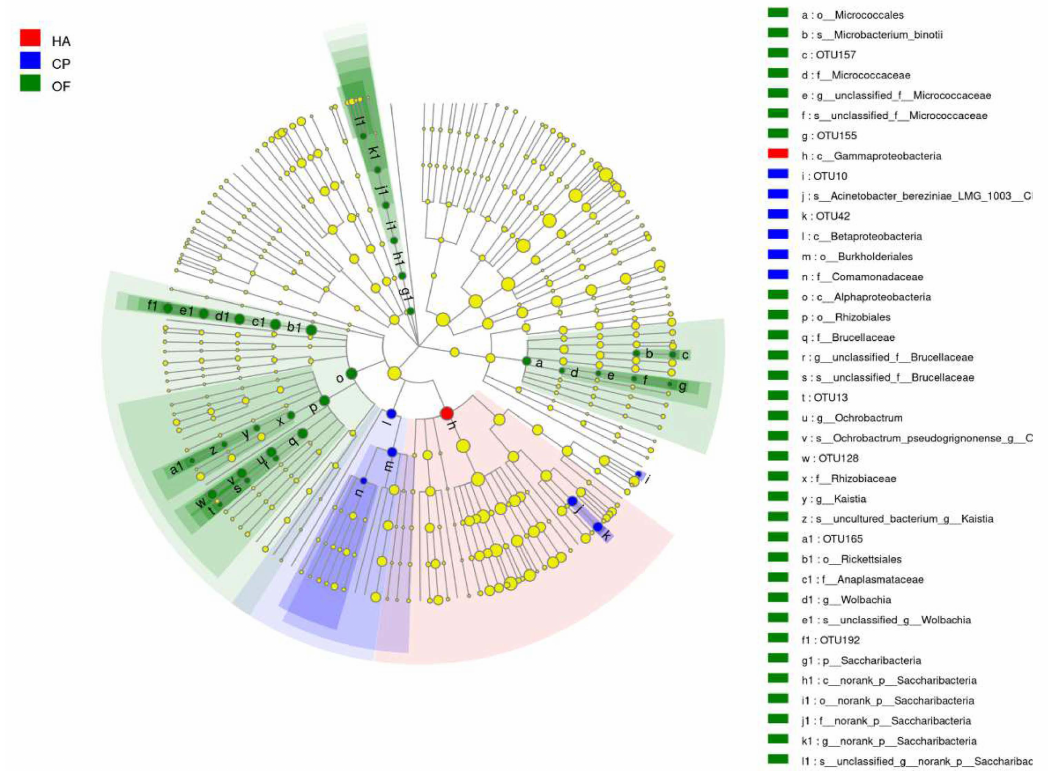
Figure 3. Cladogram of bacterial biomarkers, from the phylum (innermost ring) to species (outermost ring) level, with an LDA score >2. Each small circle at different taxonomic levels represents a taxon at that level, and the diameter of the circle is proportional to the relative abundance. The coloring principle is to color the species with no significant difference as yellow and the other different species as the group with the highest abundance of the species. Different colors represent different groups, and nodes with different colors represent the communities that play an important role in the group represented by the color. HA, H. armigera ; CP, C. punctiferalis ; OF, O. furnacalis